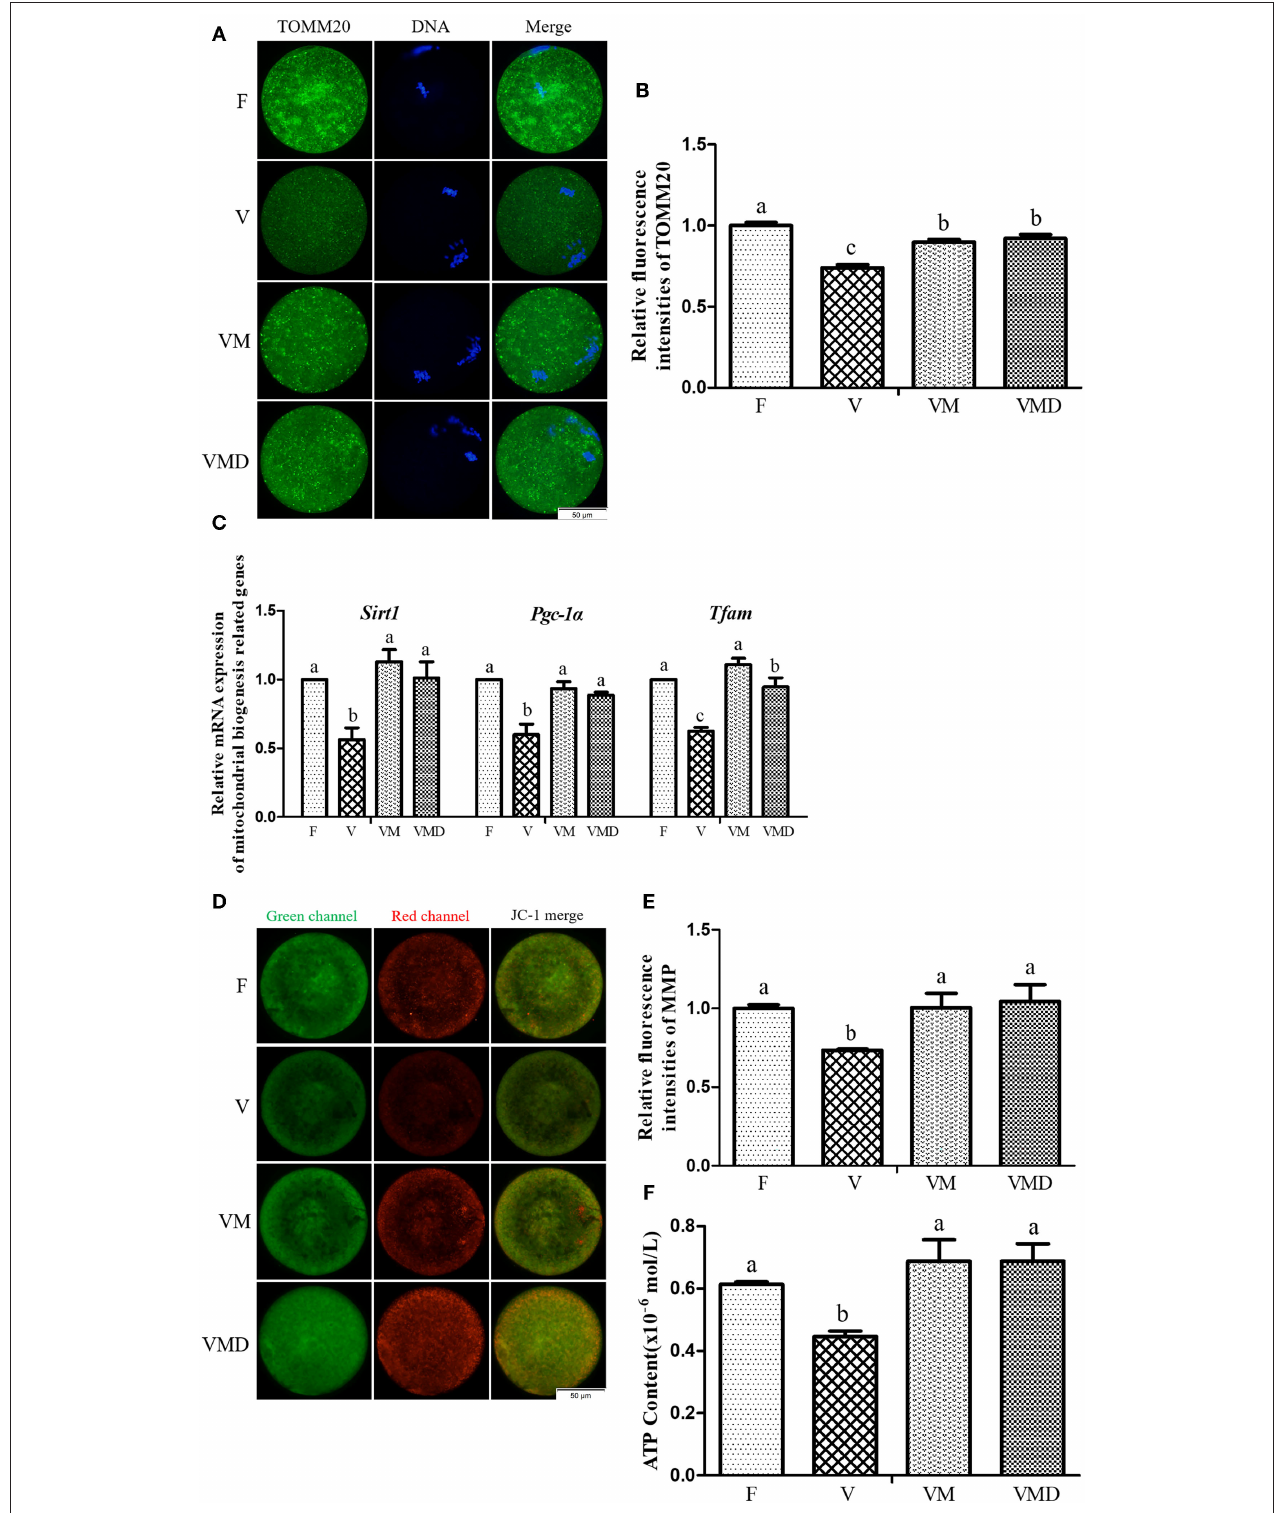
FIGURE 4 | Effects of melatonin on mitochondrial mass and mitochondrial function in MII oocytes derived from vitrified-warmed mouse GV oocytes. (A) Representative images of TOMM20 in mouse MII oocytes. Scale bar, 50 µ m. (B) The fluorescence intensity of TOMM20 was recorded using ImageJ software. In total, n = 197 MII oocytes were used in this assay (F: n = 53; V: n = 49; VM: n = 48; VMD: n = 47). (C) The expression levels of mitochondrial biogenesis related genes.